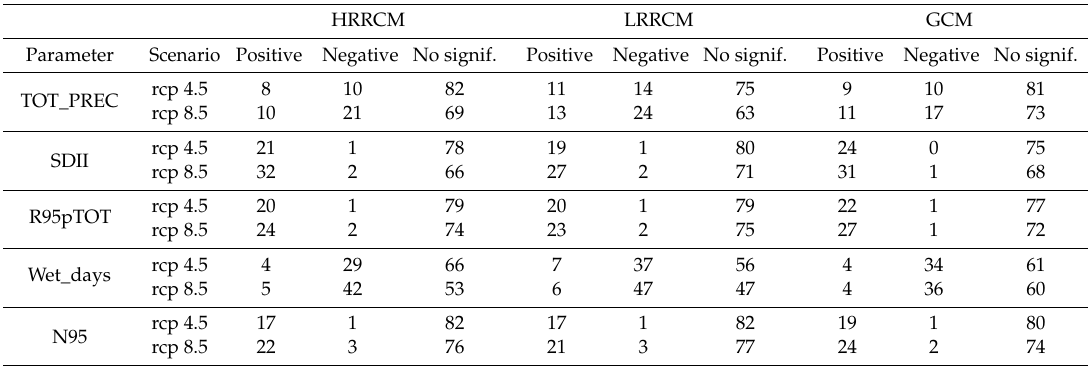
Table 5. Same as Table 4, except that it refers to the period 2071–2100.